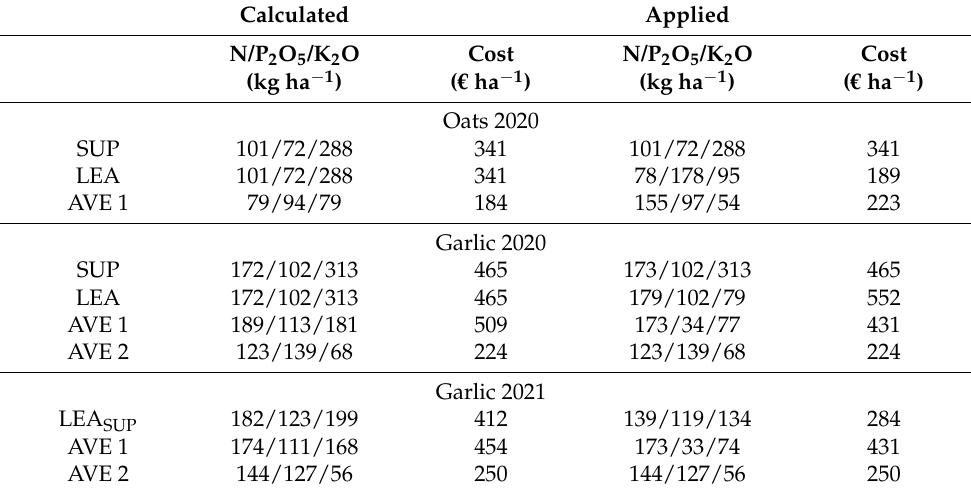
Table 4. Calculated and applied amounts of